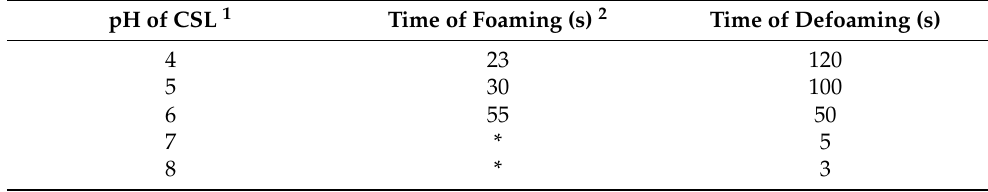
Table 2. The foaming ability and bubble-holding ability of corn steep liquor with different pH. pH of CSL 1 Time of Foaming (s) 2 Time of Defoaming